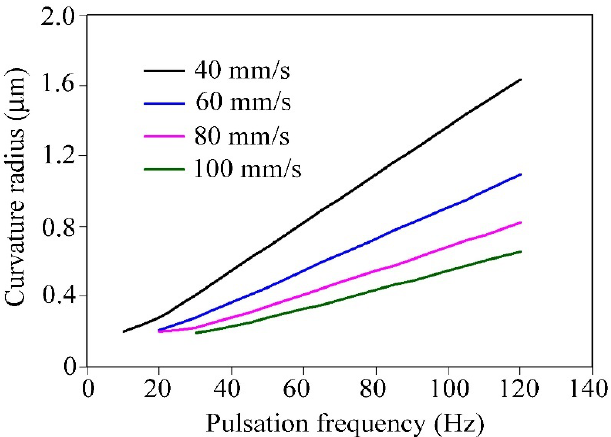
Figure 10. Dependence of the liquid droplet curvature radius on the air flow pulsation frequency (for different electrode feeding rates).